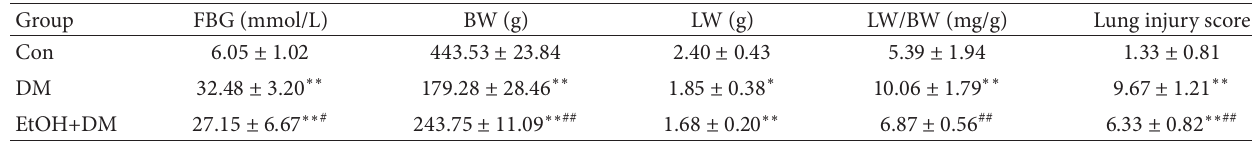
Table 1: Changes of fasting blood glucose level (FBG), body weight (BW), lung weight (LW), lung weight/body weight (LW/BW), and lung injury score in different groups.